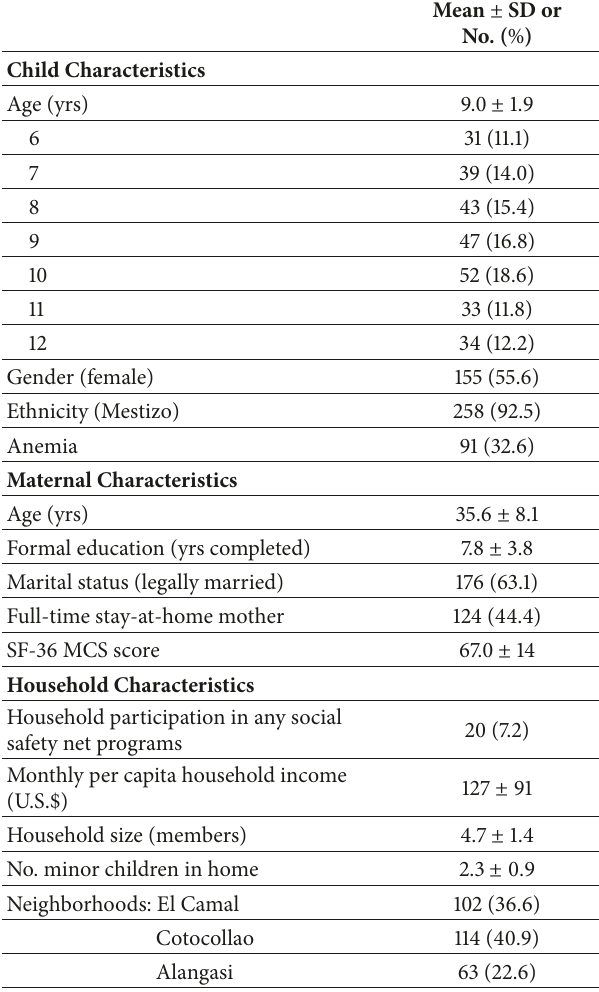
Table 1: Sample sociodemographic characteristics